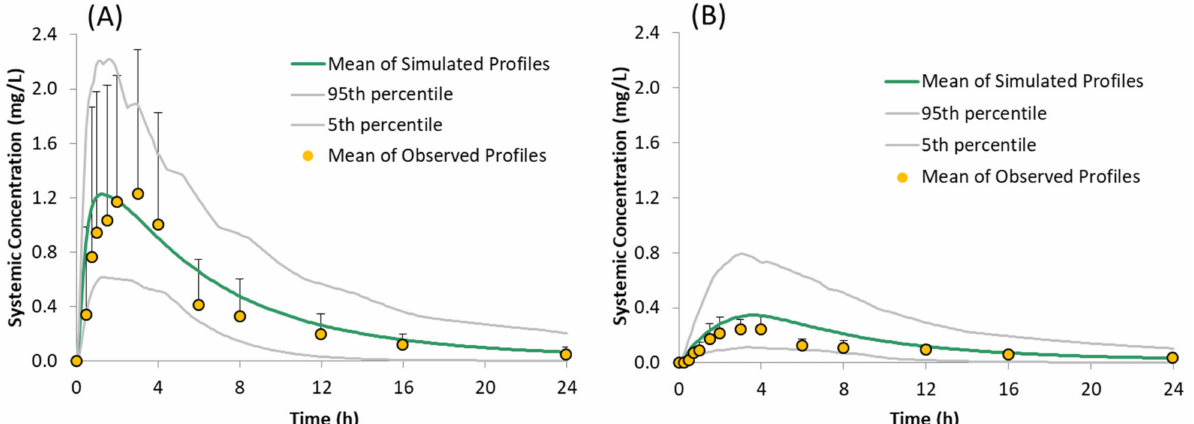
Figure 5A. The results demonstrate that the simulated PK profiles adequately reproduced the observed data. The predicted/observed ratios for the mean profile are within 1.5 fold for PK parameters C max and AUC 0–t (Table 4).